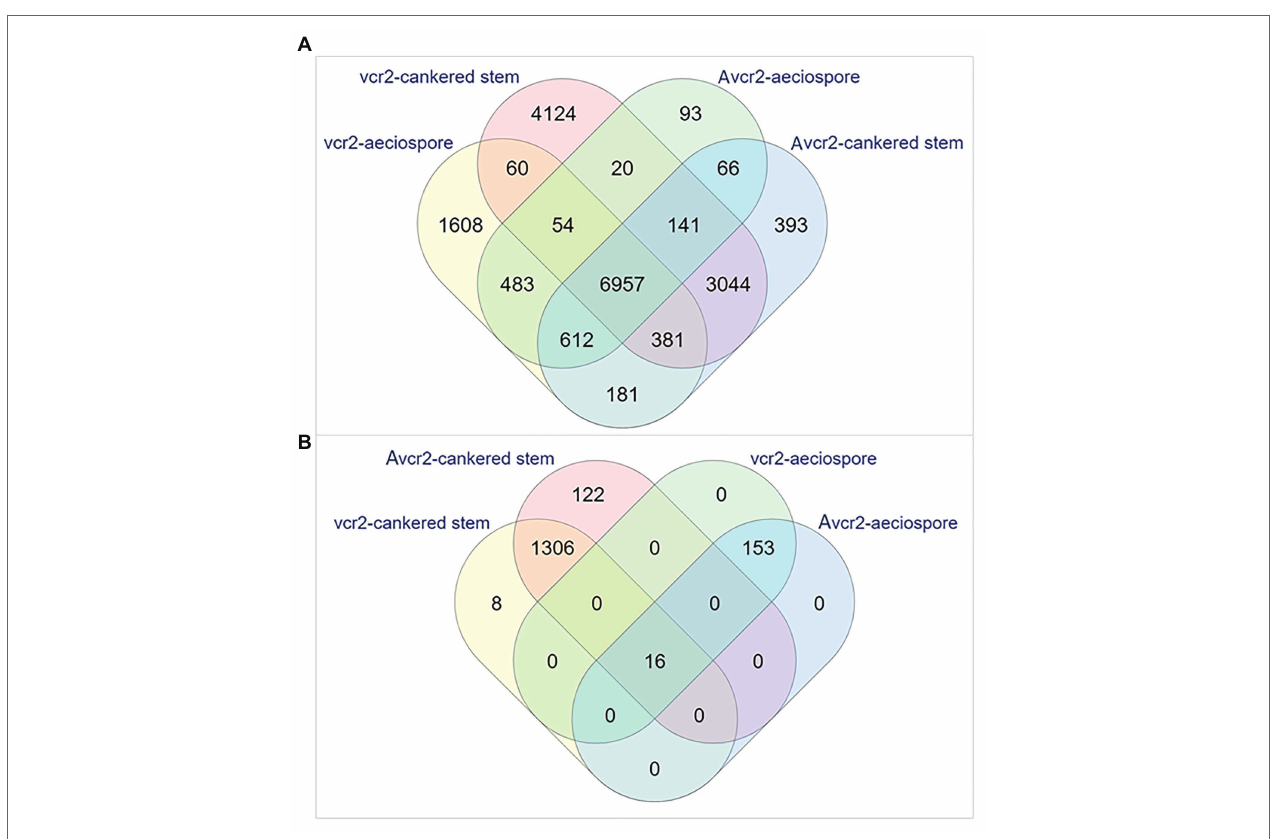
FIGURE 2 | Venn diagrams representing numbers of the expressed unigenes. The expressed unigenes were counted in aeciospore and cankered stem with FPKM > 1. (A) Overlap of total genes expressed in vcr2 and Avcr2 pathotypes. (B) Distribution of differentially expressed genes (DEGs) by comparison of vcr2 with Avcr2